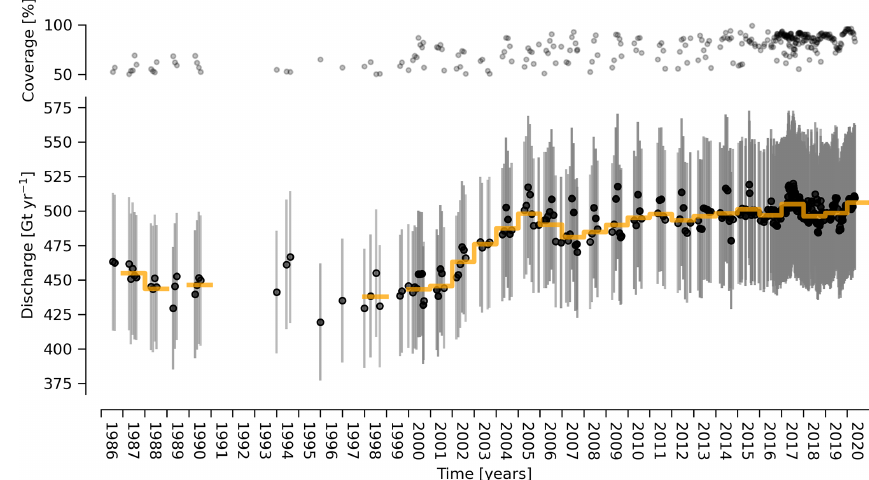
Figure 4. Bottom panel: time series of ice discharge from the Greenland Ice Sheet. Dots represent when observations occurred (limited to coverage > 50%). Orange stepped line is annual average (limited to three or more observations in a year). Coverage (percentage of total discharge observed at any given time) is shown in the top panel and also by the opacity of the dots’ interior and error bars on lower panel. When coverage is < 100%, total discharge is estimated and shown.